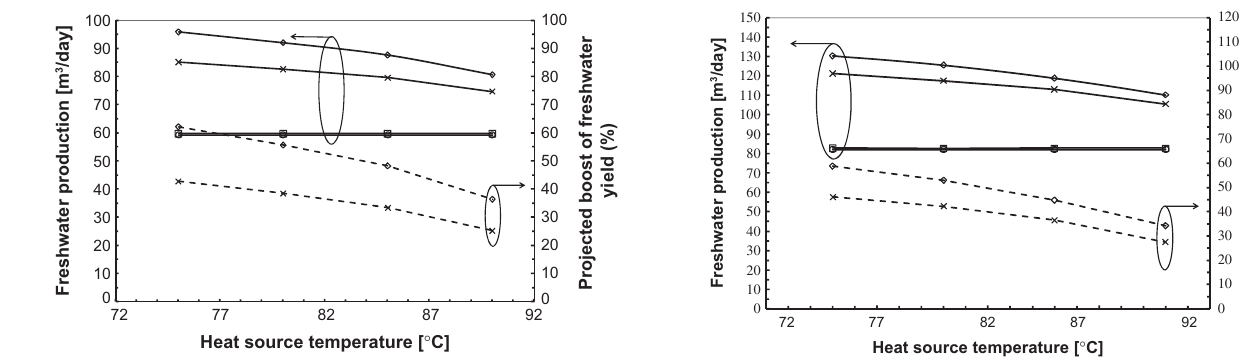
Figure 6. The efficacy of the proposed scheme as applied to a six- effect distillation plant. s , freshwater yield in a standard four-effect distillation plant at a cooling water temperature of 25 (cid:2) C; h , freshwater yield of a standard four-effect distillation plant at a cooling water temperature of 32 (cid:2) C. e , freshwater yield and improvement by using our proposed design at 25 (cid:2) C; · , freshwater yield and improvement by using our proposed design at 32 (cid:2) C